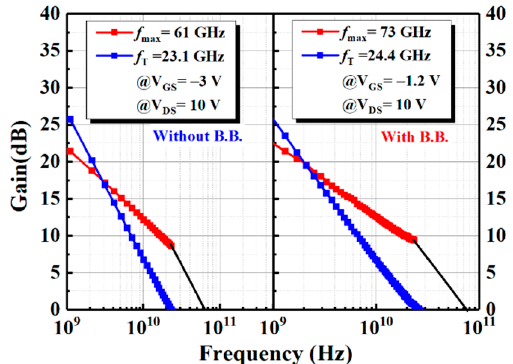
Figure 4. Small-signal characteristics of 0.25- μ m gate quaternary AlGaN/GaN HEMT.